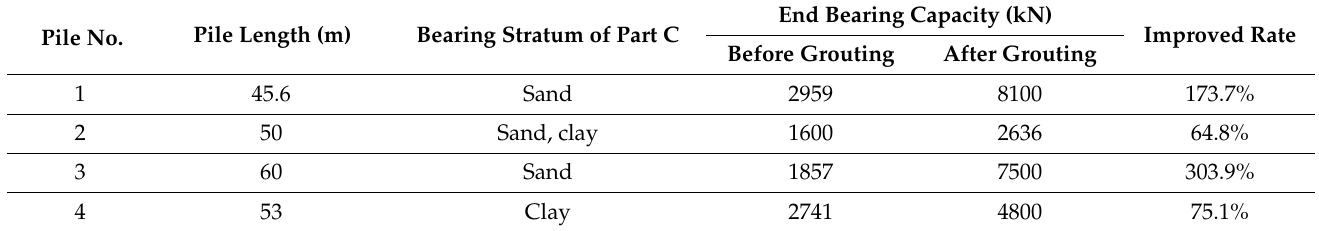
Table 6. Interpreted end bearing capacities of test